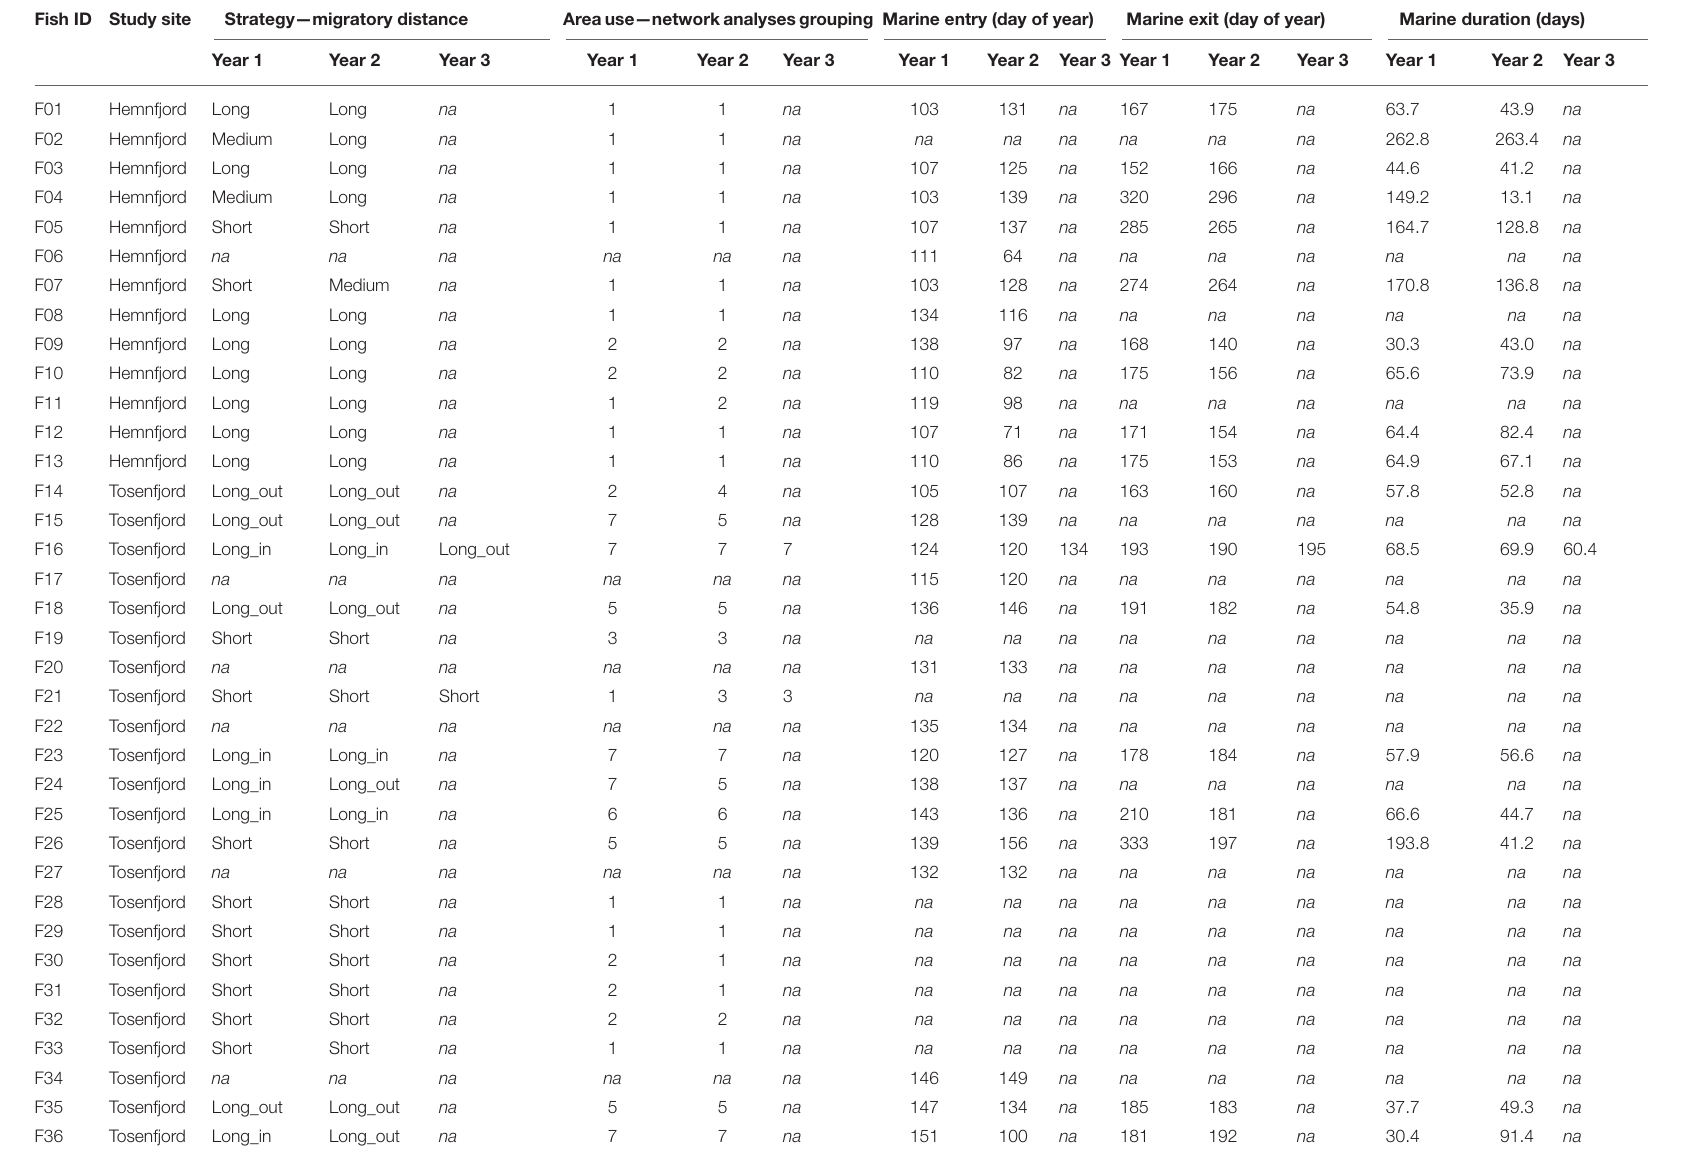
TABLE 2 | Summary of individual’s behavioral characteristics among years of tracking. Fish ID Study